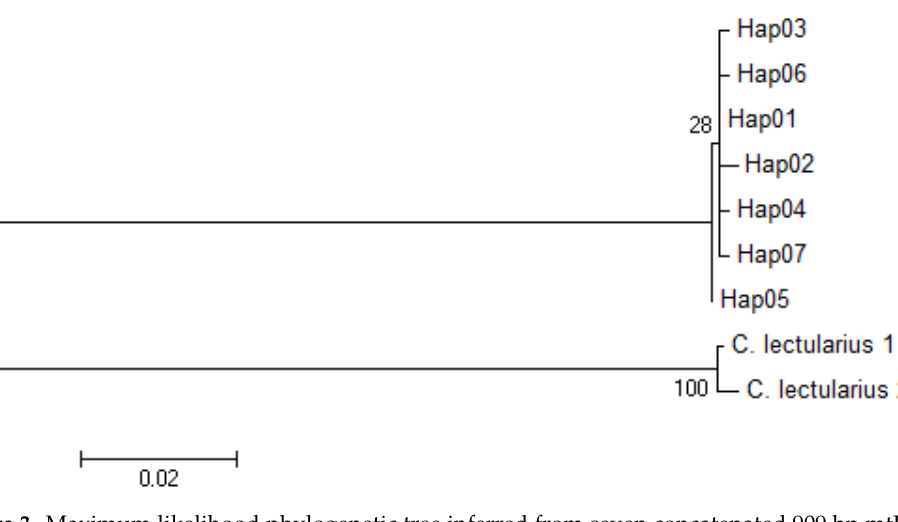
Figure 3. Maximum likelihood phylogenetic tree inferred from seven concatenated 909 bp mtDNA haplotypes. The bootstrap values were provided at each node. Details of individuals representing each haplotype were given in Table 1.